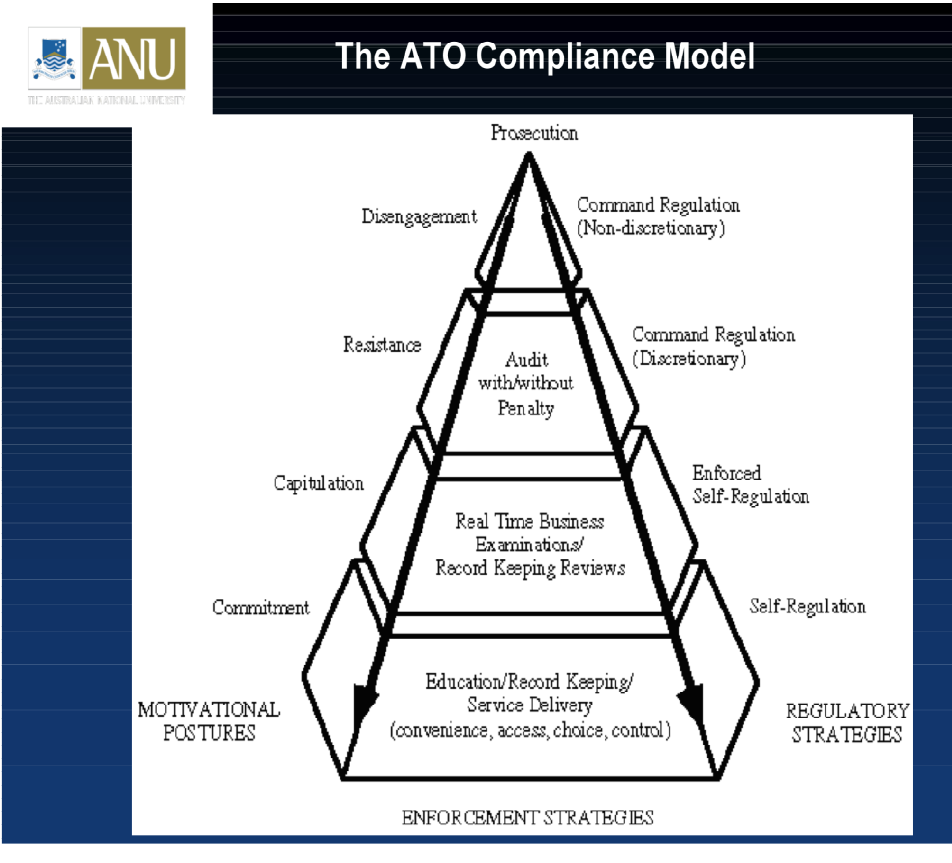
Figure 4 ATO Model of Compliance from “An Evolving Compl iance Model for Tax Enforcement” by Valerie Braithwaite and John